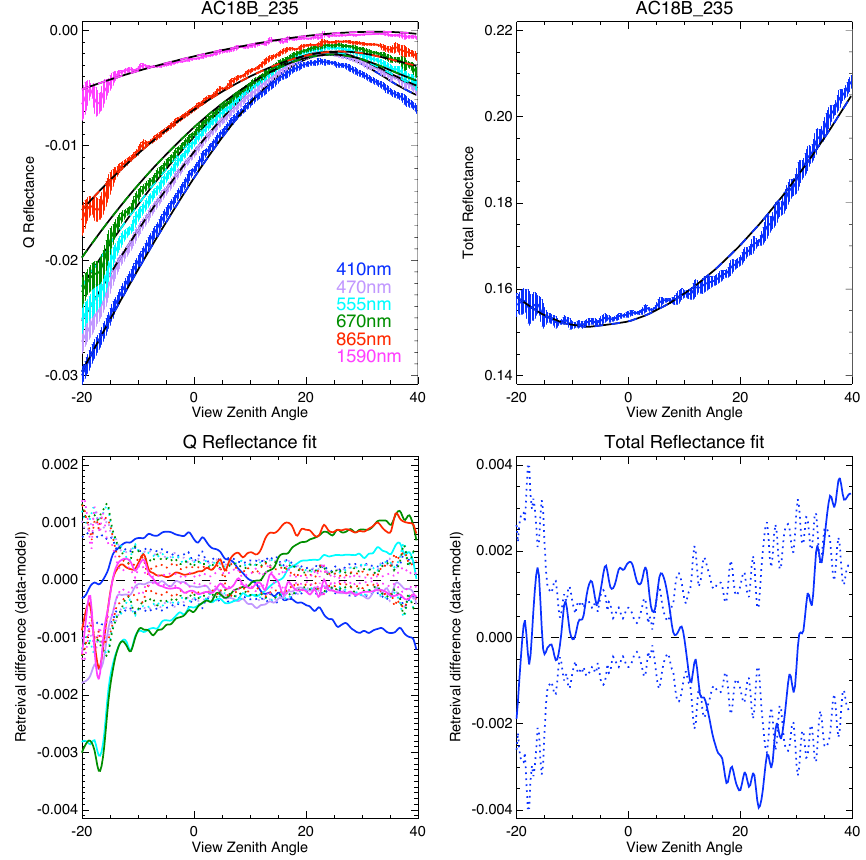
Fig. 2. Sample results from an optimization using HSRL data. In the top panels, measured reflectances, and their associated errors, are plotted with solid lines with respect to the view zenith angle. Model results are plotted with dashed lines. Negative view zenith angles indicate aircraft forward scan directions, while positive values represent aft observations. R Q is plotted on the left, while R I is on the right. The bottom panels display the measurement minus model residuals. Dotted lines in these panels indicate the total error associated with that observation. 410mn results are in blue, 470nm in purple, 555nm in cyan, 670nm in green, 865nm in red and 1590nm in